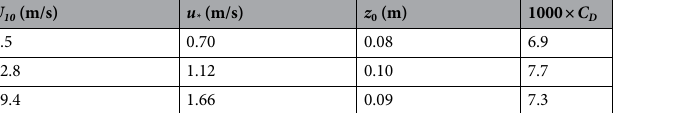
Table 1. Estimates of friction velocity ( u * ) and aerodynamic roughness length ( z 0 ) obtain by a log wind profile fit.